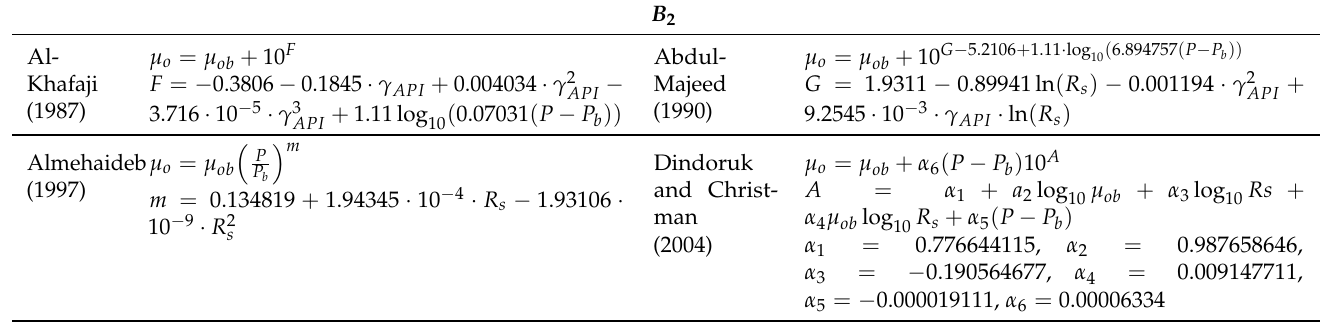
Table 4. Correlations in cluster B 2 .